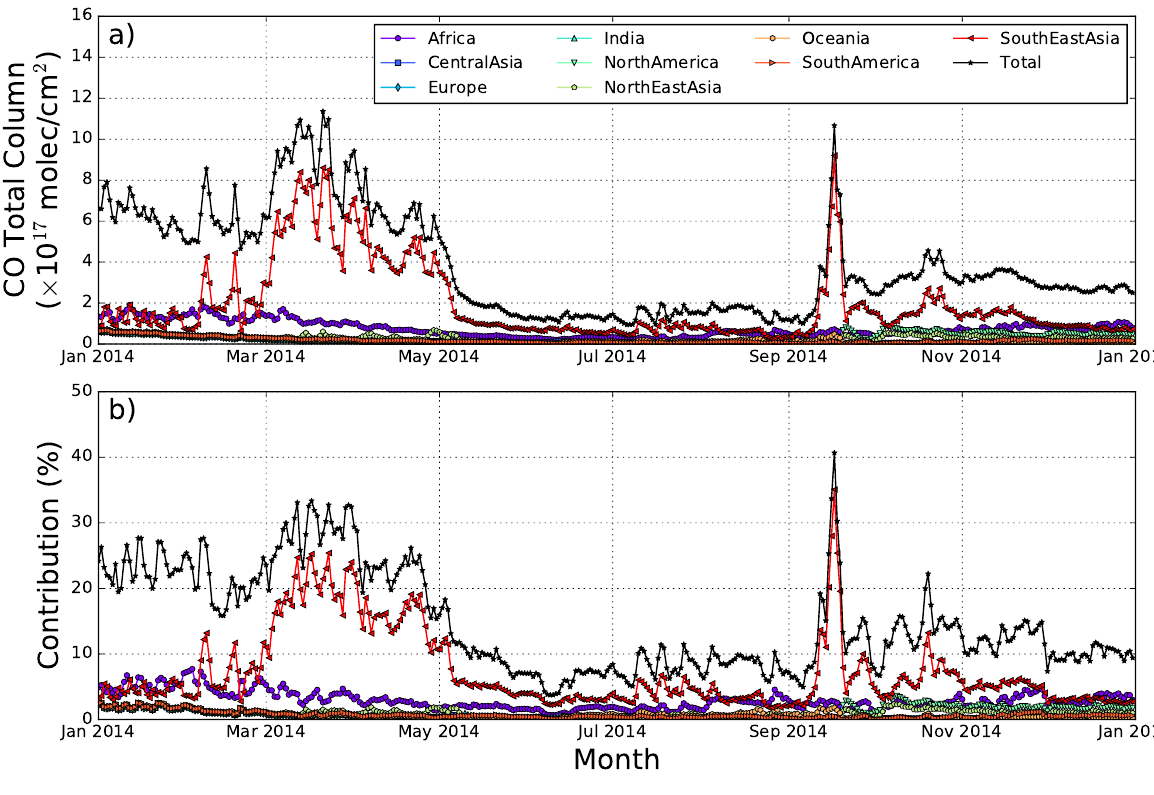
Figure 7. The absolute contribution of biomass burning CO total columns from different source regions (a) and their relative contribution to the CO total columns (b) over Hong